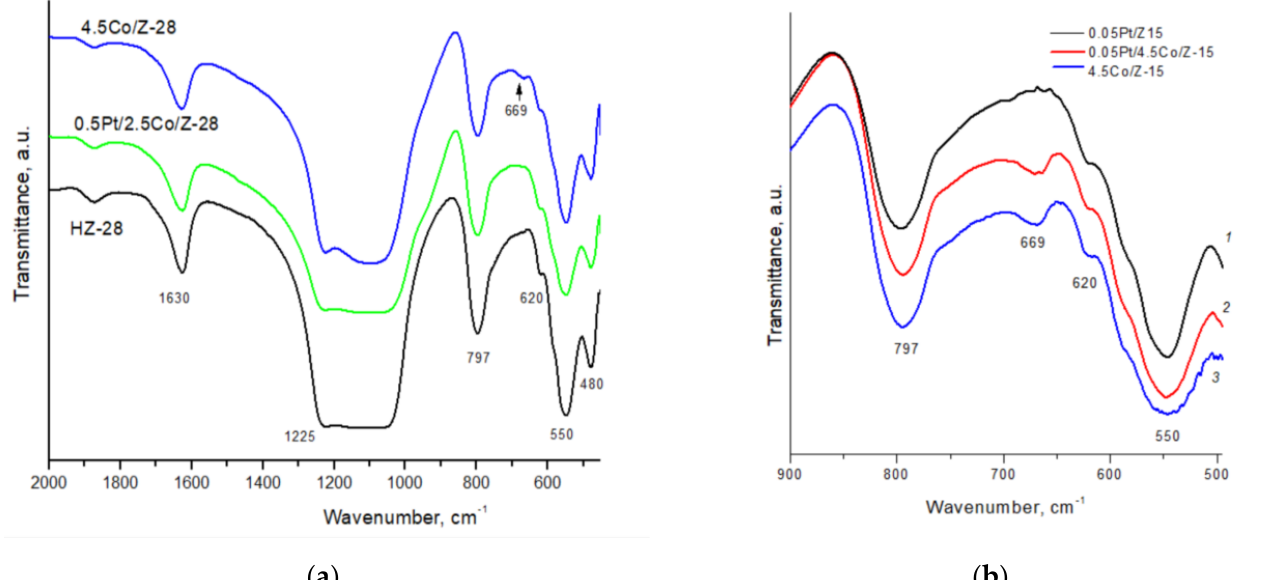
Figure 3. FTI − pectra of ( a ): HZ-28, 0.05Pt/2.5Co/Z-28, and 4.5Co/Z-28; ( b ): 0.05Pt/Z-15 (1), 0.05Pt/4.5Co/Z-15 (2), and 4.5Co/Z-15 (3) in KBr.